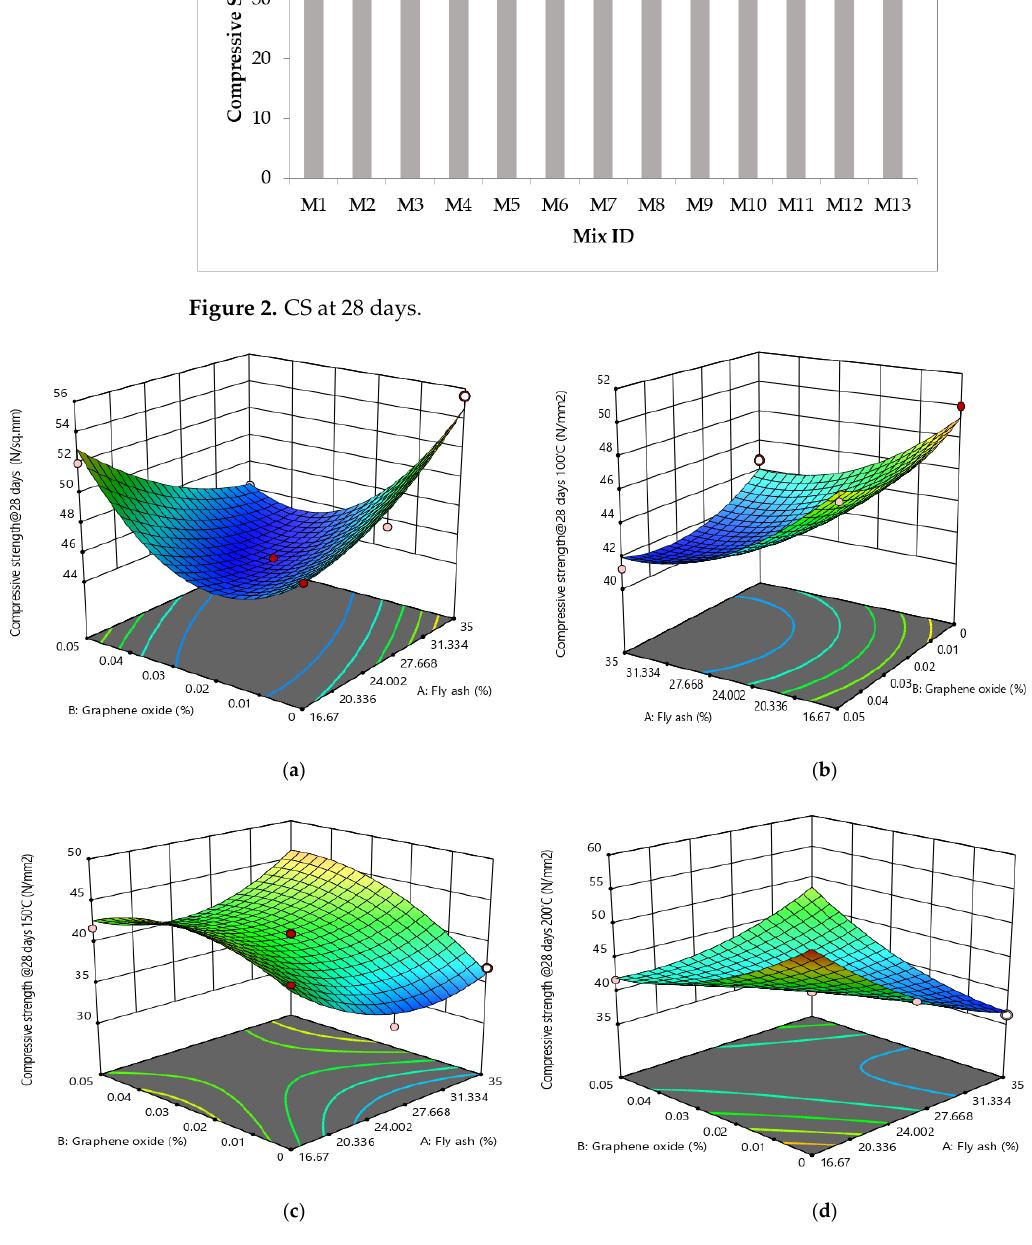
Figure 3. Response surface plots for 28-day CS: ( a ) 24 °C; ( b ) 100 °C; ( c ) 150 °C; ( d ) 200 °C.